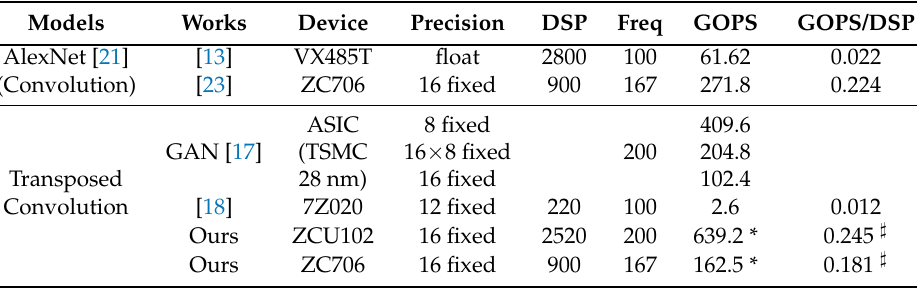
Table 7. Comparison to prior